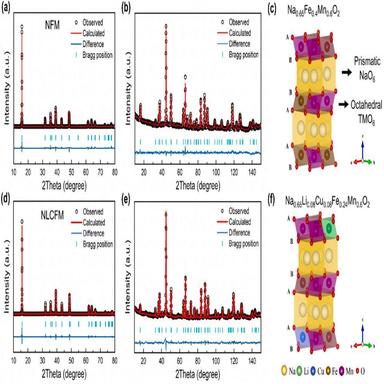
Crystal structure characterization on powder samples of NFM and NLCFM. (a–b, d–e) Observed and calculated XRD and NPD profiles for NFM and NLCFM: (black) observed; (red) calculated; (blue) difference plot; (green bars) Bragg reflections. (c, f) Schematic illustration of the crystal structure of NFM and NLCFM.